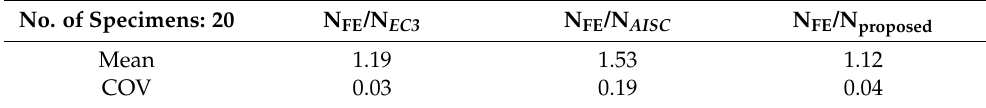
Table 6. Comparison of proposed design method and code predictions with FE results of LC1-1100. No. of Specimens: